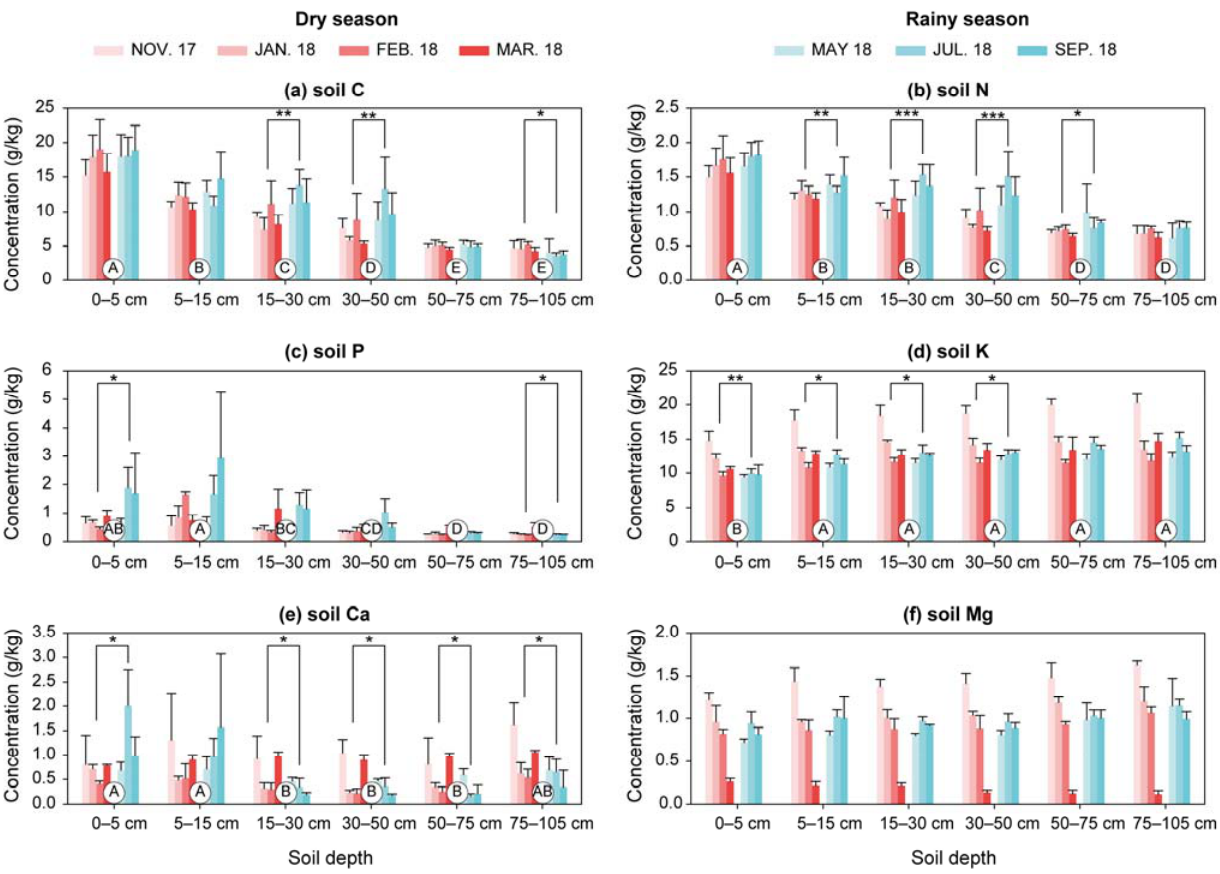
Figure 1. Concentrations of ( a ) C, ( b ) N, ( c ) P, ( d ) K, ( e ) Ca, and ( f ) Mg in different soil layers. Different uppercase letters indicate significant differences among soil layers ( p ≤ 0.01), and the asterisks above the connecting lines indicate significant differences in the nutrient concentration between the dry season and rainy season (* indicates p ≤ 0.05, ** indicates p ≤ 0.01, *** indicates p ≤ 0.001).